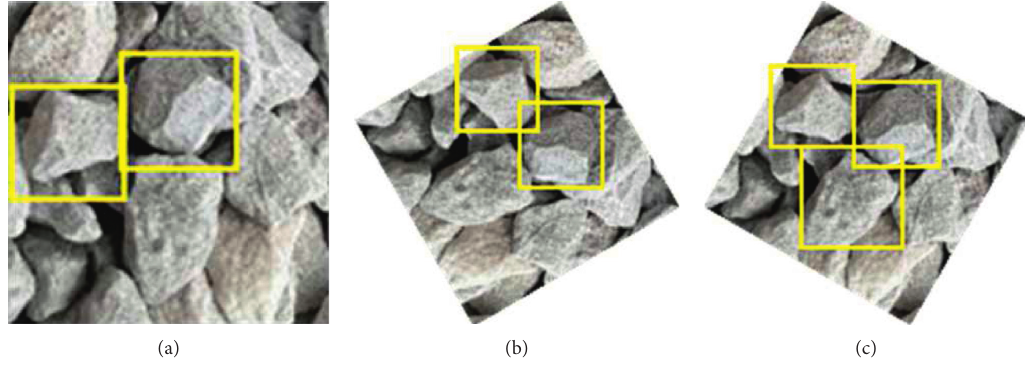
Figure 4: Schematic of rotation: (a) 0 ° ; (b) 30 ° ; (c) 60 °